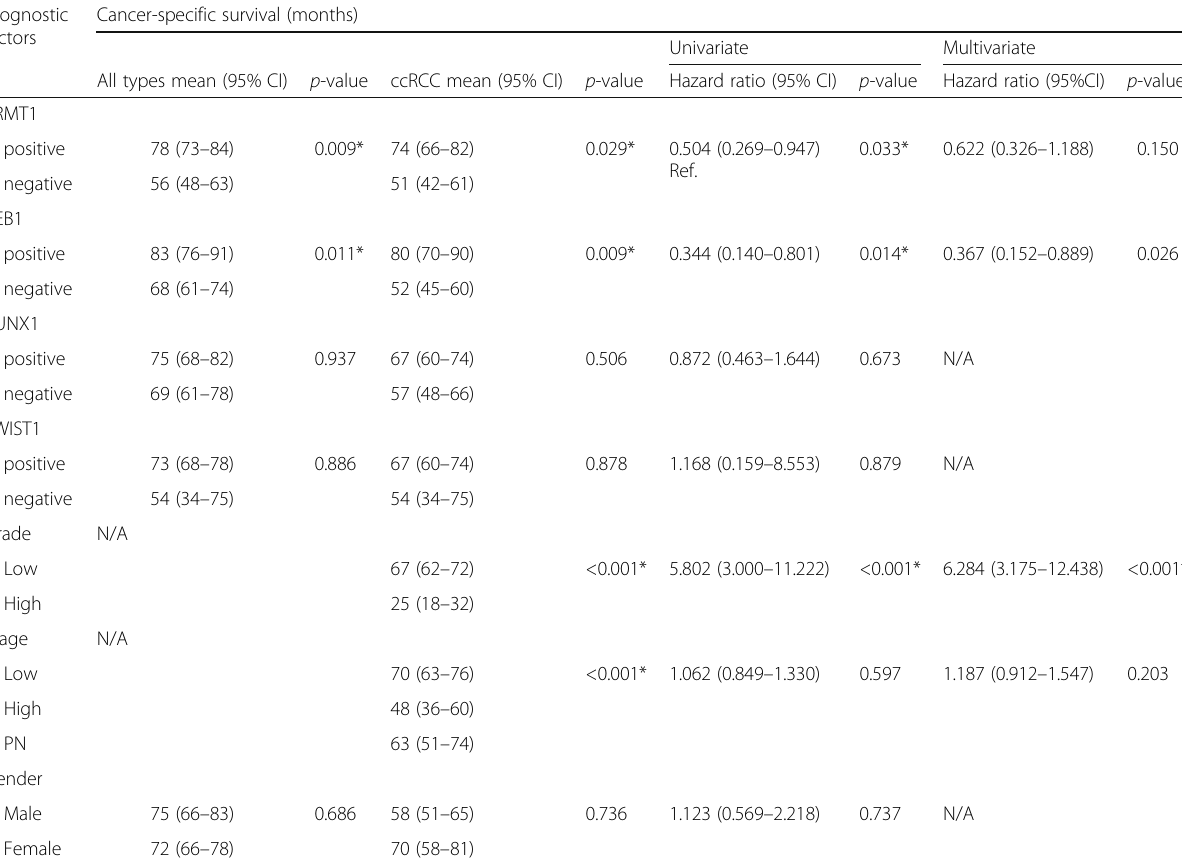
Abbreviations: PRMT 1 protein arginine methyltransferase 1, ZEB 1 Zinc Finger E-Box Binding Homeobox 1, RUNX 1 Runt-related transcription factor 1, TWIST 1 Twist Family BHLH Transcription Factor 1, CI confidence interval, PN partial nephrectomy, ref . referent value. *Statistically significant p